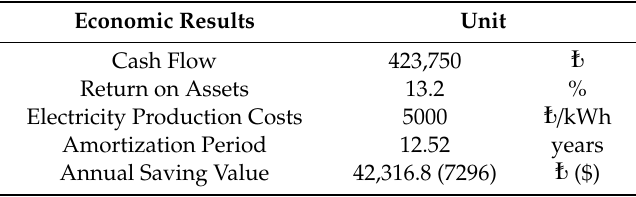
Table 8. The PV*SOL Output Results.